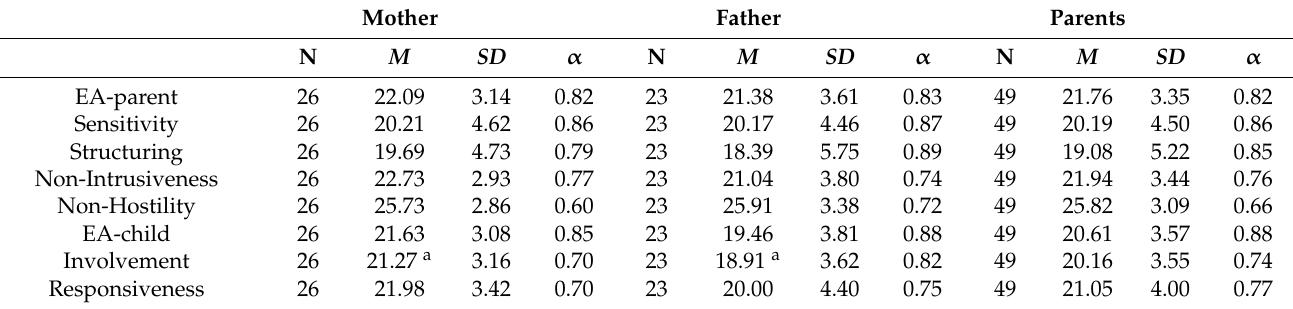
Table 2. Descriptive statistics of parents’ emotional